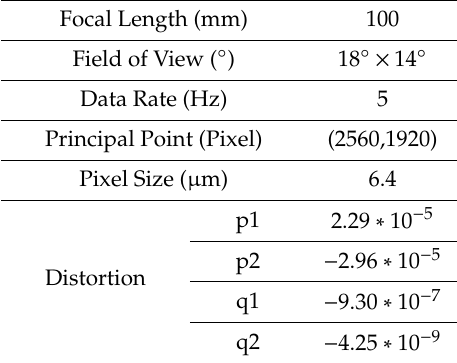
Table 1. Geo-Positioning Errors Decomposition.